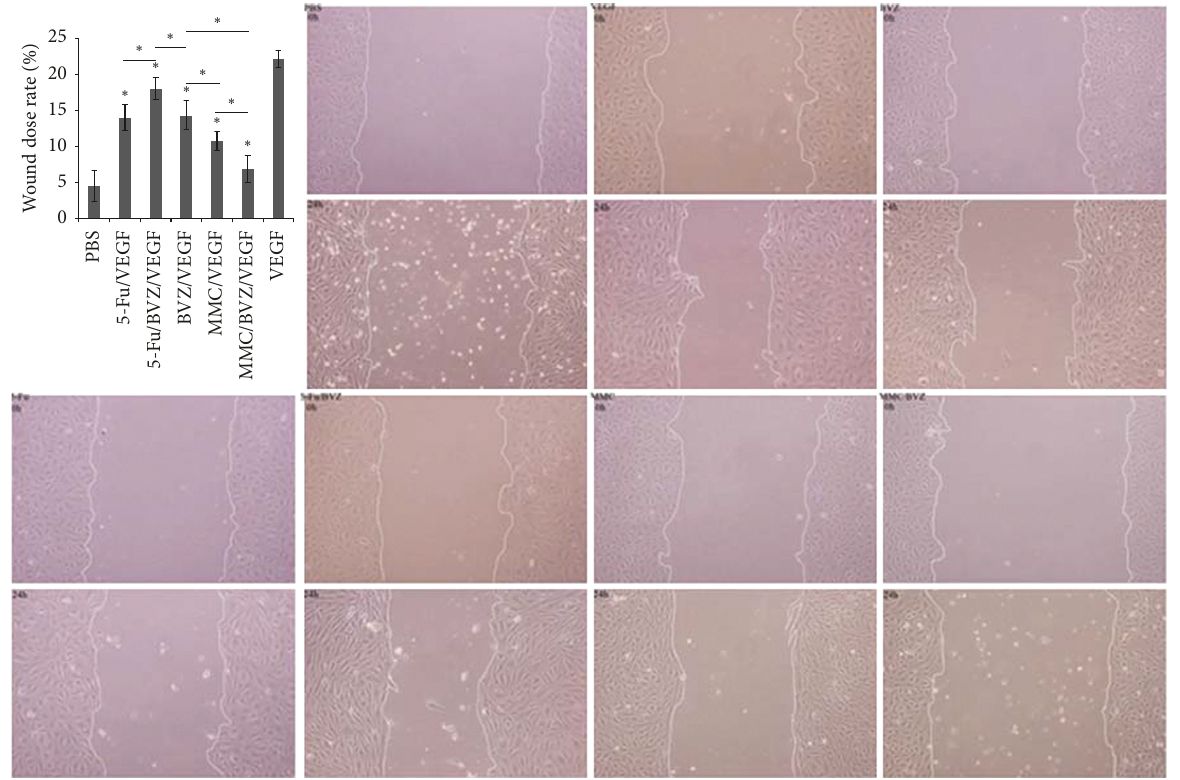
Figure 4: Cell migration analysis. The scratch-wound assay of human umbilical vein endothelial cells (HUVECs) after treatment with bevacizumab (BVZ), mitomycin C (MMC), 5-fluorouracil (5-Fu), MMC+BVZ, and 5-Fu+ BVZ on the migration of endothelial cells under the action of vascular endothelial growth factor (VEGF). ( P 0 . <